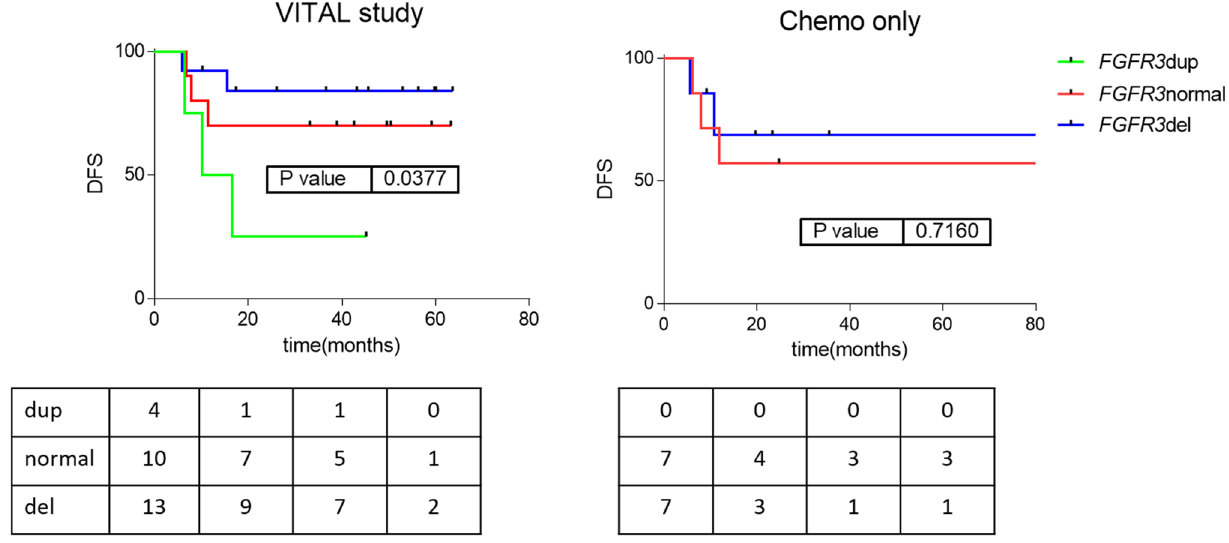
Figure 4. Survival curves for relevant EGFR-family receptors. Disease-free survival curves for VITAL clinical trial and chemoradiotherapy cohort patients according to FGFR3 status. HR between normal-del vs duplication = 4.30 (CI95% 1.28–88.25) dup: FGFR3 duplication; normal: FGFR3 wild type; del: FGFR3